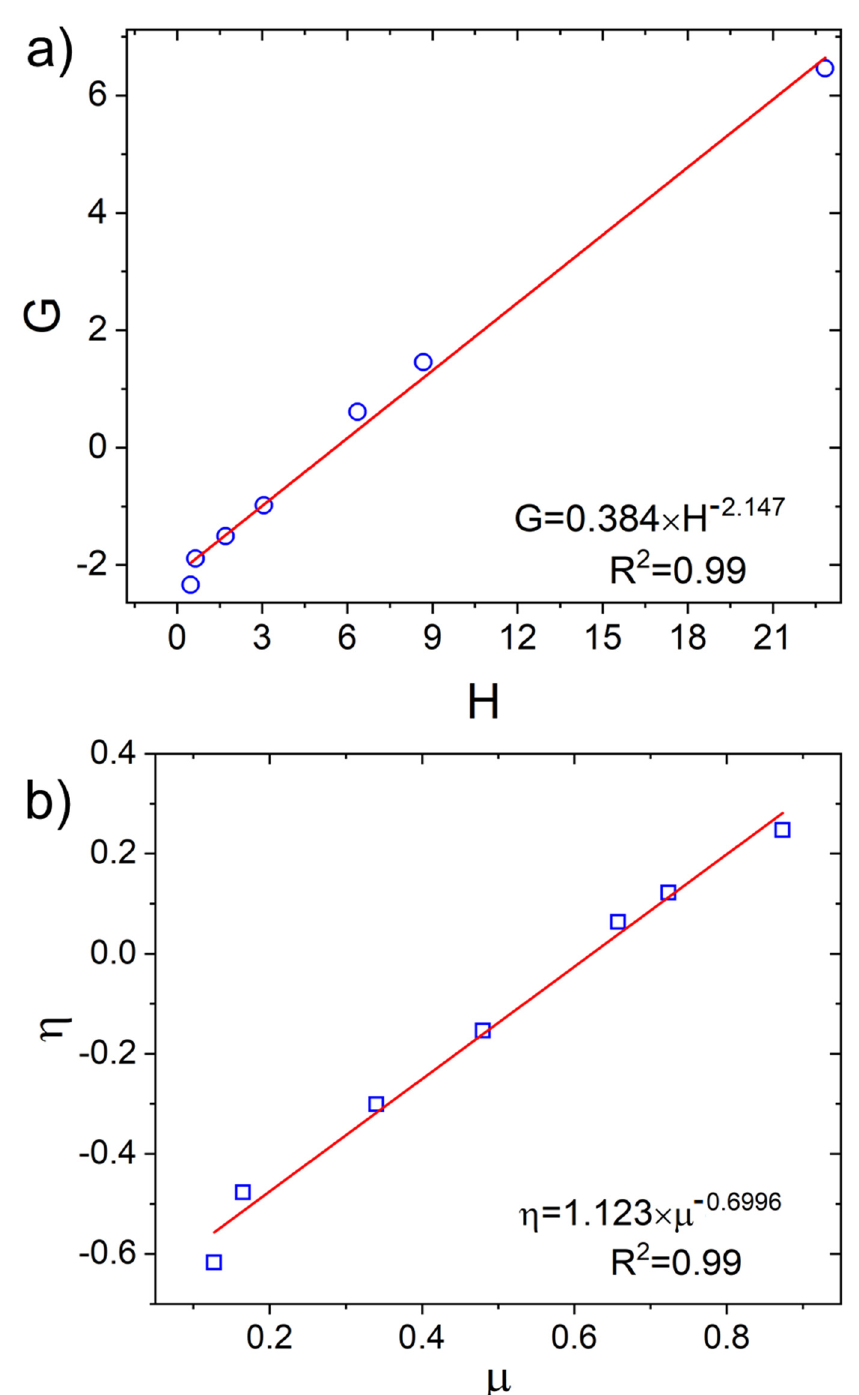
Figure 5. Determination of reactivity ratios for the CMRP of VDF and 1234yf by ( a ) Fineman − Ross and ( b ) Kelen − Tüdös models by OMRcP mediated by Co(acac) 2 and initiated by bis( tert -butylcyclohexyl) peroxydicarbonate (P16).